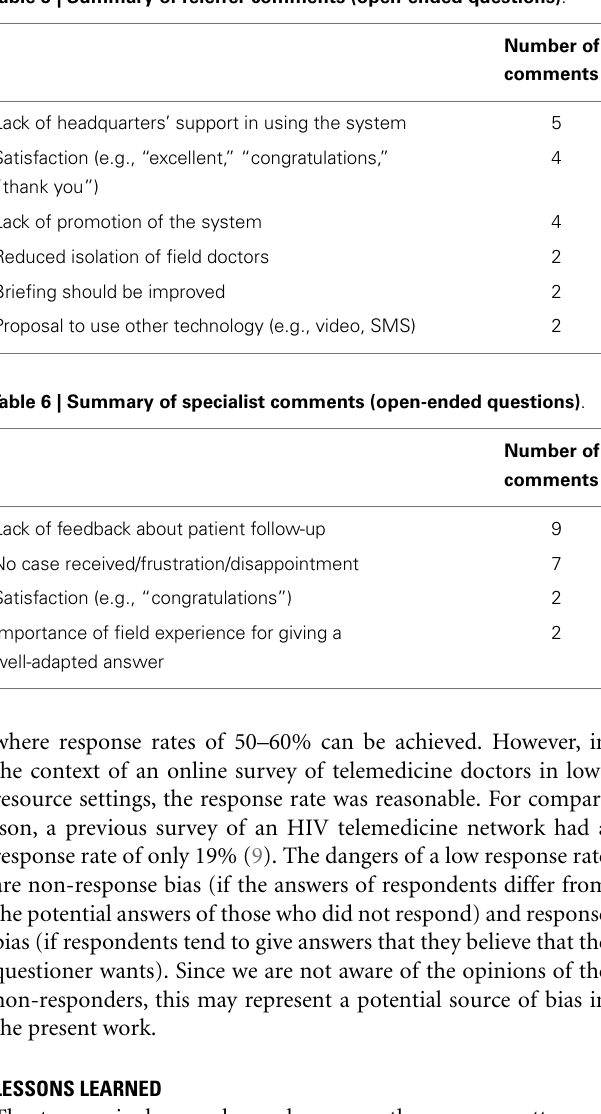
Table 5 | Summary of referrer comments (open-ended questions) .